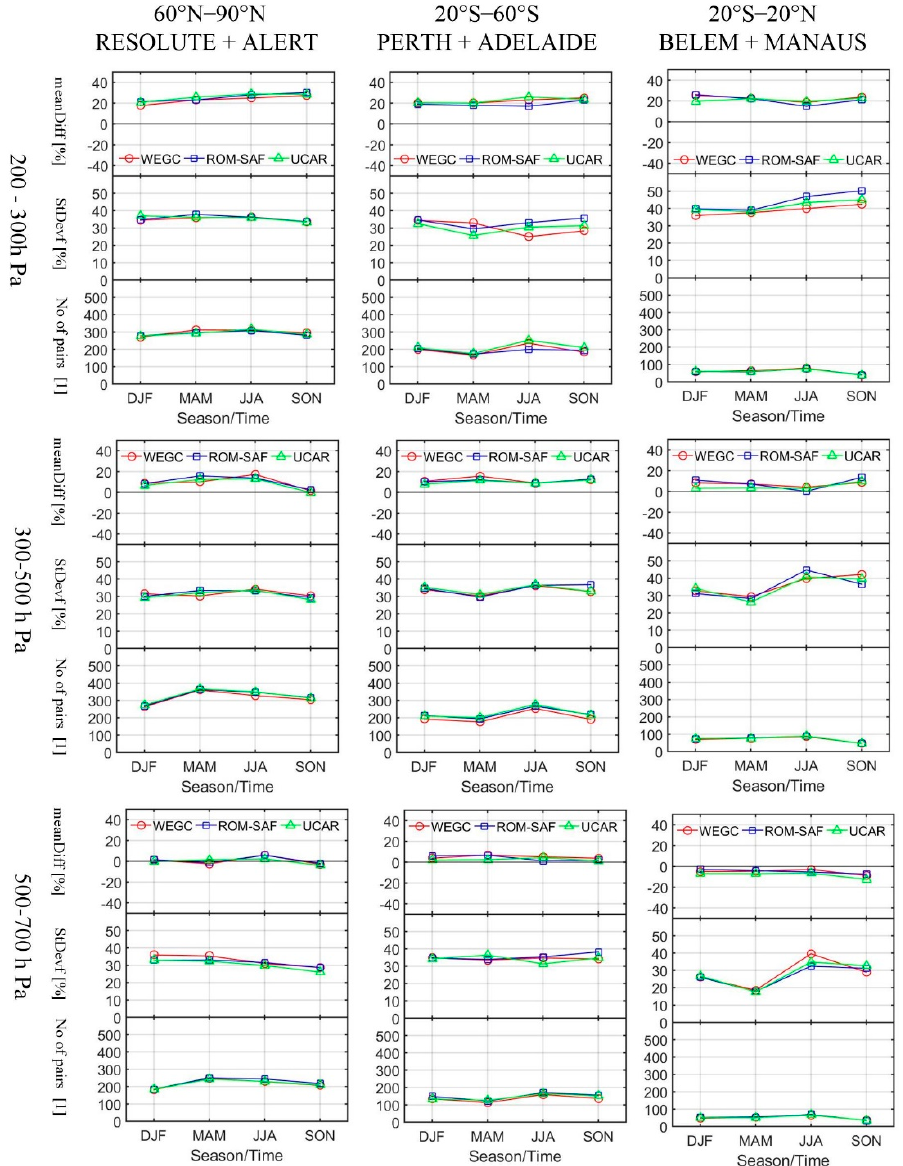
Figure 9. Mean specific humidity differences (meanDiff, top row of each sub-panel) with standard deviations (StDev, middle row) between RO and RS and number of paired samples (bottom row) over selected stratospheric layers for the four temporal phases of DJF, MAM, JJA, and SON; from top to bottom, selected stratospheric layers are 200–300 hPa, 300–500 hPa, and 500–700 hPa, respectively; from left to right, results for latitudinal bands of 60°–90°N, 20°–60°S and 20°S–20°N are shown respectively.